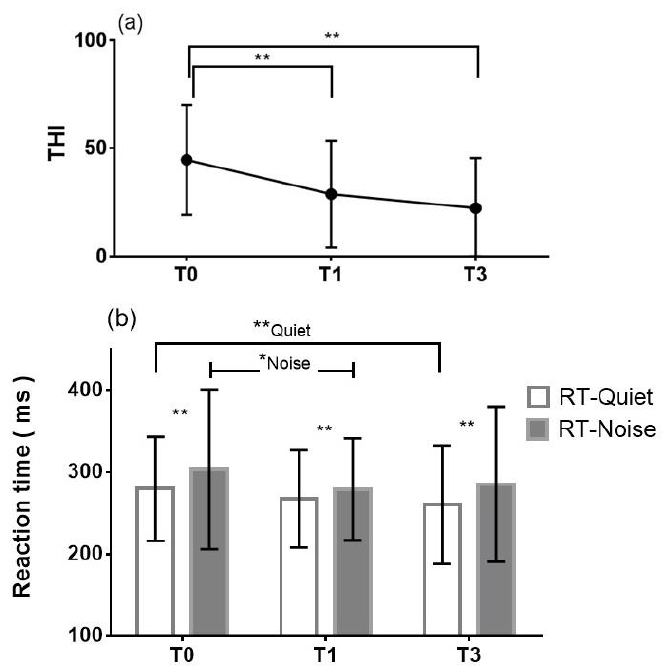
Figure 2. (a) Mean THI total score and (b) mean reaction time in quiet and with noise at pretreatment (T0), 1 month after treatment (T1) and 3 months after treatment (T3). THI = Tinnitus Handicap Inventory; RT-Quiet = mean reaction time in quiet conditions; RT-Noise = mean reaction time with noise. * p < 0.05. ** p < 0.01.